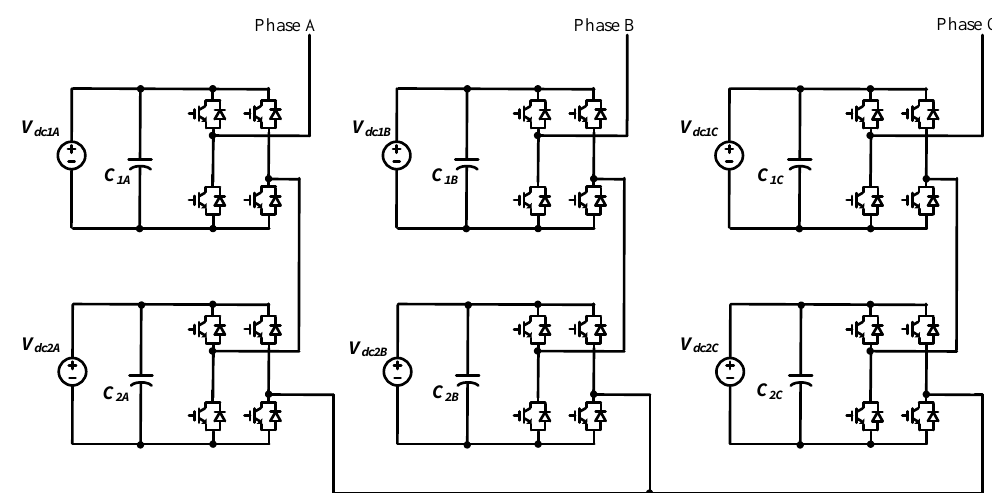
Figure 1. Construction of traditional three-phase cascaded H-bridge (CHB) inverter topology.